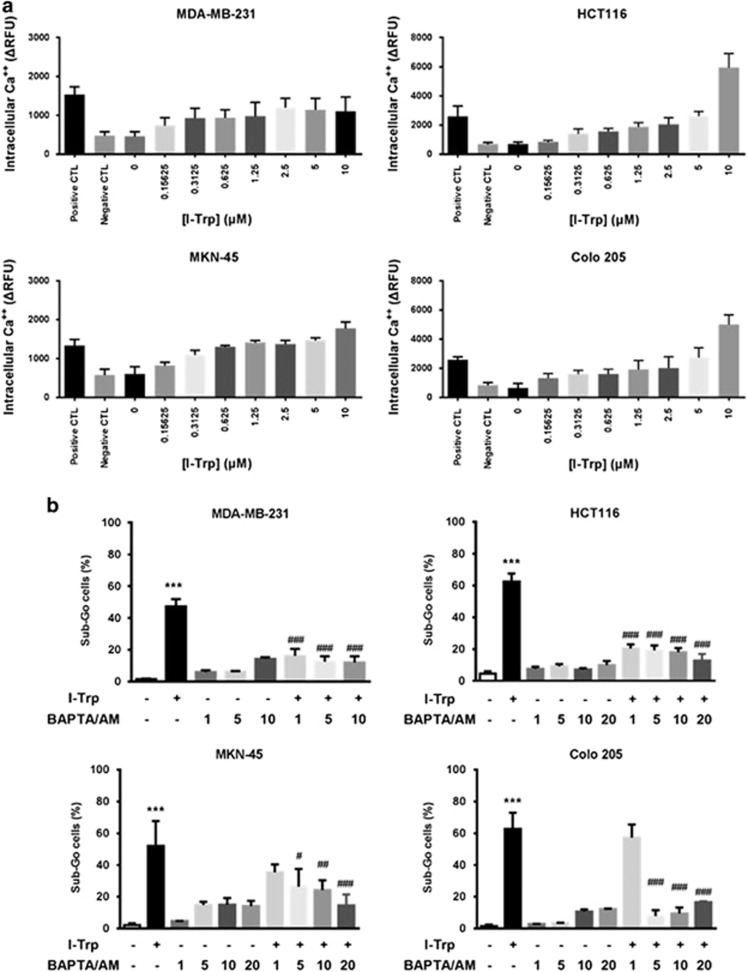
Effect of I-Trp on the levels of intracellular Ca2+. (a) I-Trp induces intracellular Ca2+ release in a concentration-dependent manner. Cells were pretreated with BAPTA/AM (negative control) for 1 h, with MCN-A-343 (positive control) or different concentrations of I-Trp and incubated with Fluo-4 for 40 min. After incubation, the fluorescence signal was immediately measured using a fluorescence microplate reader by excitation at 509 nm and emission at 516 nm. (b) Cells were pre-incubated with BAPTA/AM (1–20 μM) for 1 h prior to treatment with EC50 concentrations of I-Trp for 72 h. Cell apoptosis was assessed via PI-based flow cytometric analysis. Data are expressed as mean±S.D. ***P<0.001, significant difference as compared to control. #P<0.05, ##P<0.01 and ###P<0.001 significant difference as compared to I-Trp alone